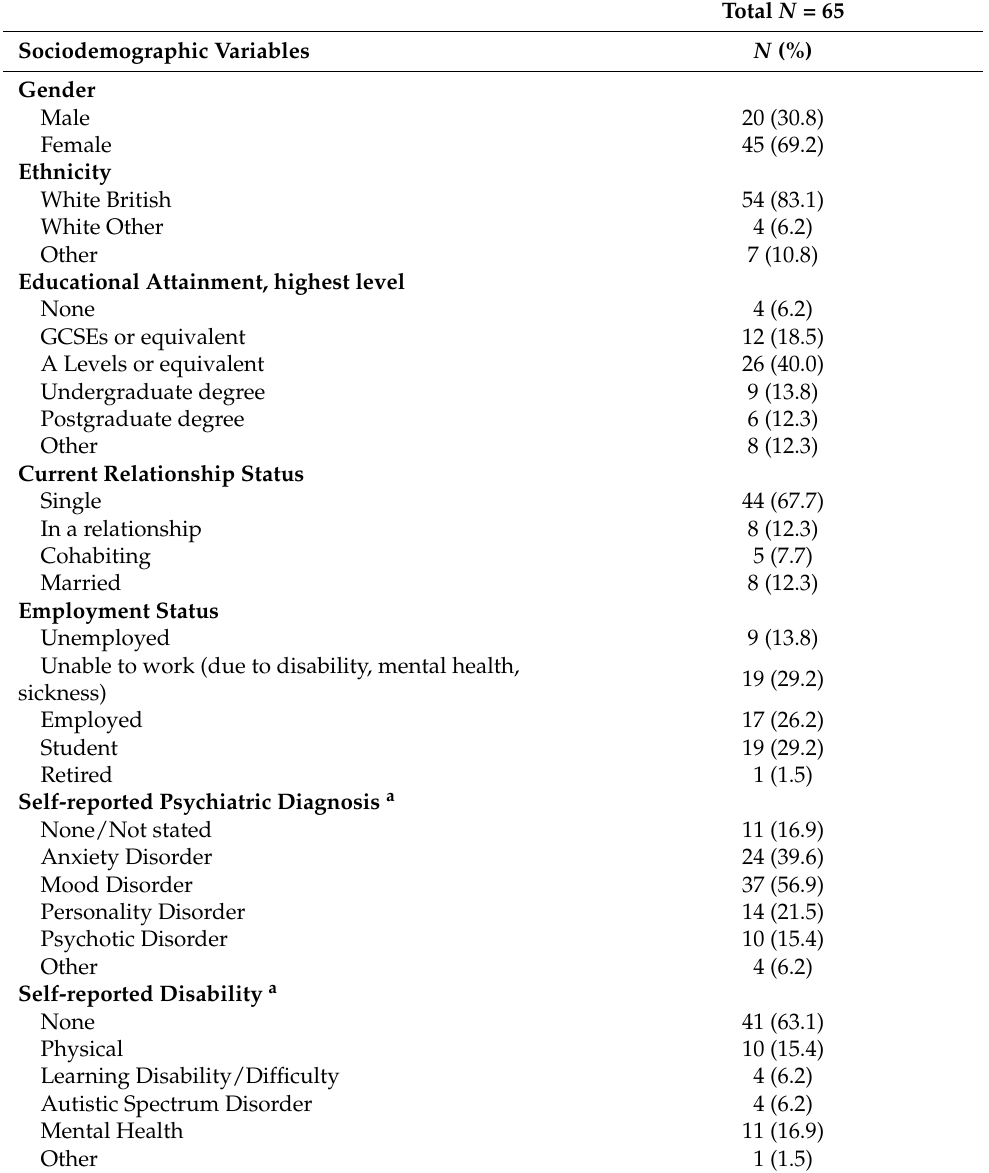
Table 1. Sociodemographic characteristics.